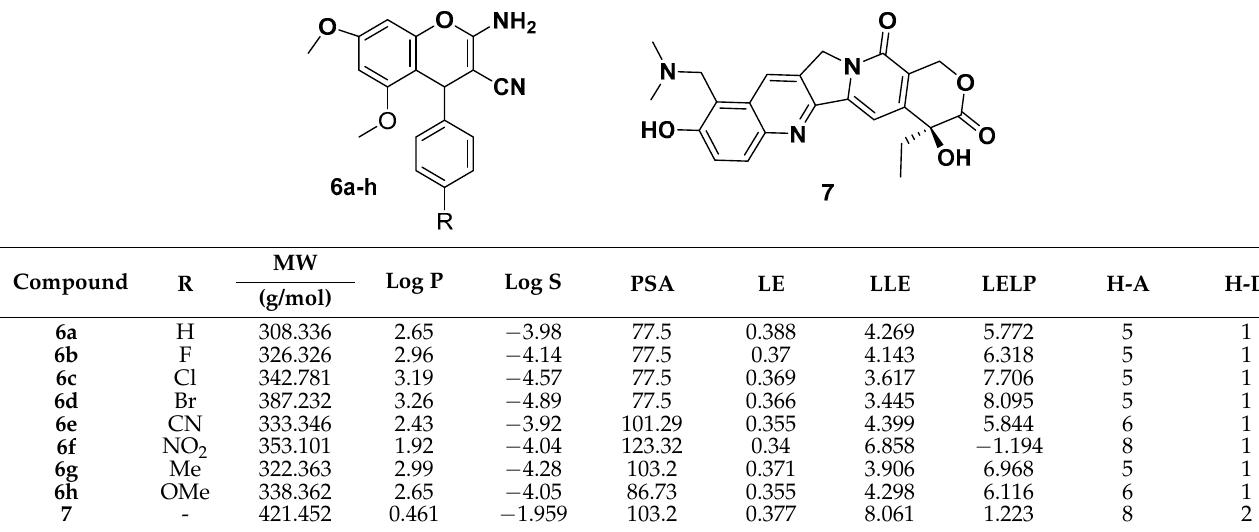
Table 4. Calculated physicochemical properties of 2-amino-3-cyano-4 H -chromenes 6a–h and topotecan 7 as inhibitors of topoisomerase I.